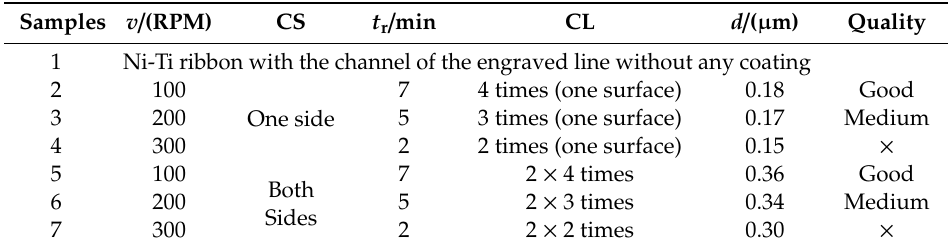
Table 1. Specification of the various samples obtained by spin coating: the speed of the substrate ( v ); the coating surface (CS); the residence time ( t r ) of the coating; the number of the coating layer (CL); the coating thickness d (µm); the quality.